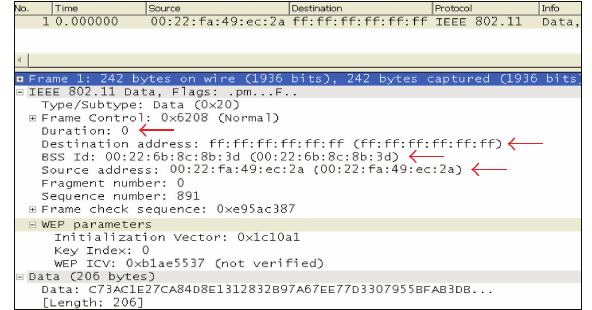
Figure 8: The chosen encrypted data